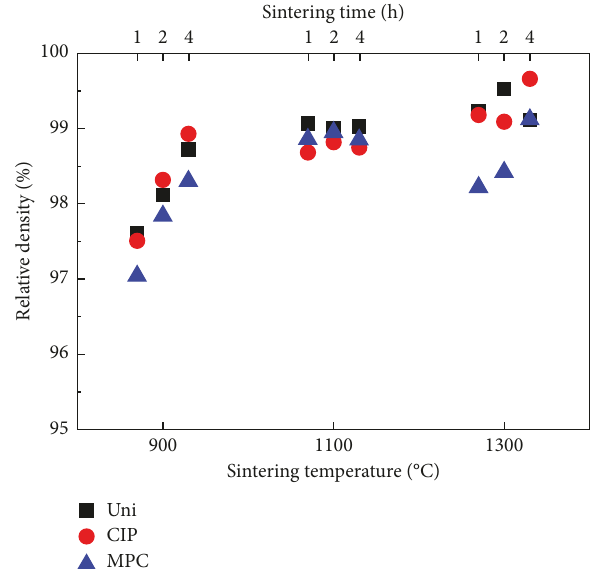
Figure 2: Variations in the relative densities of the sintered ZnO ceramics prepared using the three compacting methods (uniaxial pressing, CIP, and MPC) with respect to the sintering temperature and duration.